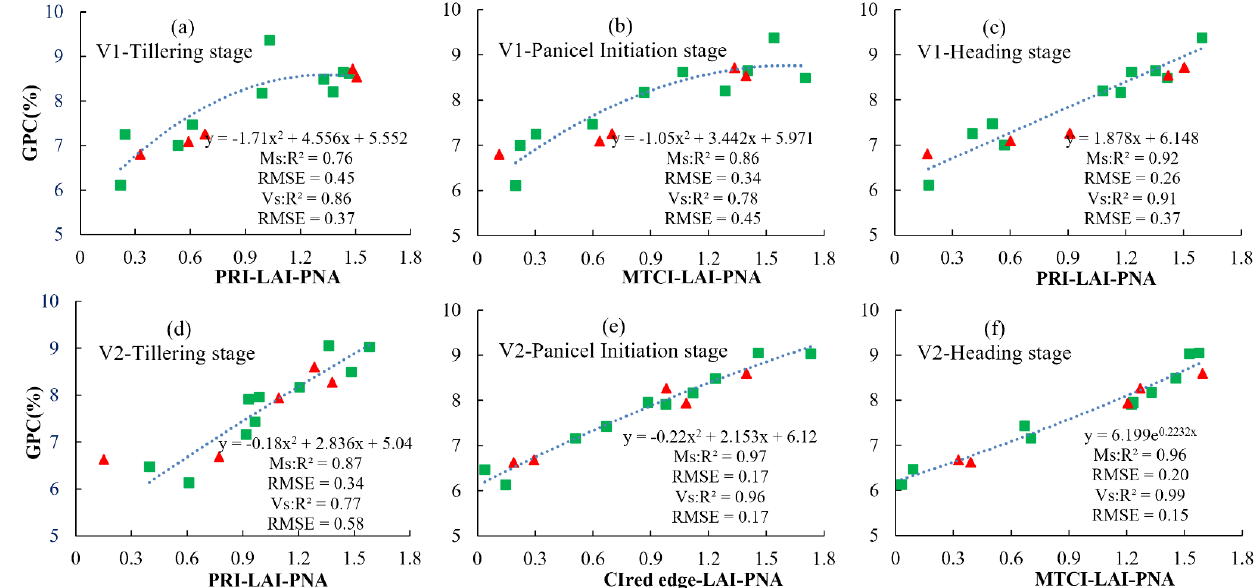
Figure 11. Scatterplots and regression models of grain protein content (GPC) and optimal three- dimensional monitoring indices for rice variety V1 (Meixiangzhan 2) at ( a ) the tillering stage, ( b ) panicle initiation stage, and ( c ) heading stage; and for variety V2 (Wufengyou 615) at ( d ) the tillering stage, ( e ) panicle initiation stage, and ( f ) heading stage.